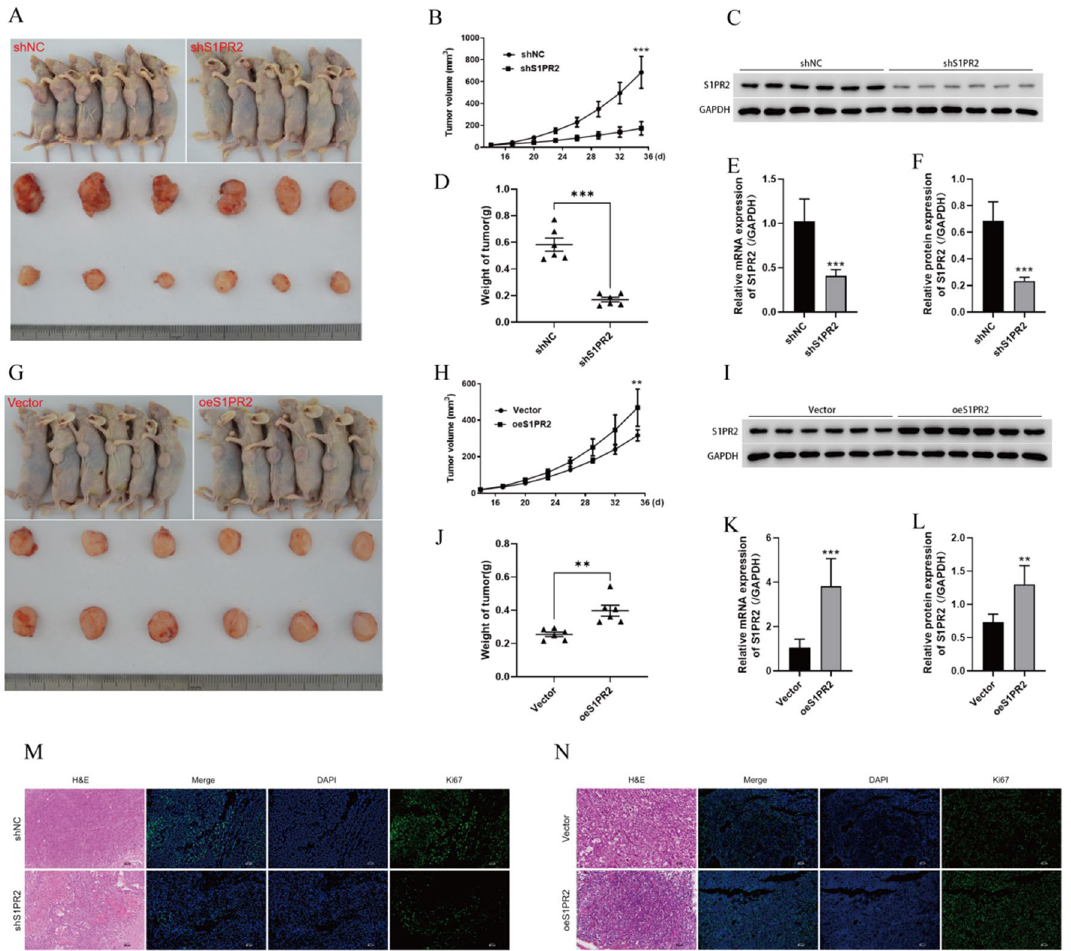
Fig. 4 Interfering with S1PR2 inhibits the growth of HCC tumours. A sh-NC and sh-S1PR2 expression in the in vivo and ex vivo tumours in nude mice; B subcutaneous tumour growth curves in sh-NC and sh-S1PR2 groups; C S1PR2 protein levels in tumour tissues observed via western blot; D weight of tumours; E S1PR2 levels of mRNA in tumour tissues observed by employing RT-qPCR; F statistical analysis of pro- tein levels of S1PR2 in relevant tissues, where S1PR2 can promote the development of HCC tumour cells; G In vivo and ex vivo tumours in nude mice in Vector and oeS1PR2 groups; H subcutaneous tumour growth curves of Vector and oeS1PR2 groups; I levels of protein of S1PR2 in tumour tissues observed using western blot; J weight of tumours; K Levels of mRNA of S1PR2 in tumour tissues revealed by RT-qPCR; L statistical analysis of protein levels of S1PR2 in relevant tissues; M , N pathological changes of tumour tissues observed by H&E staining; pro- liferation of tumour cells detected by Ki67 immunofluorescence staining. **p < 0.01, ***p <